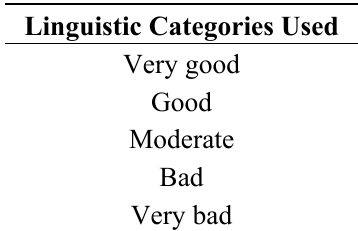
Table 7. Scale of linguistic categories used during assessment.